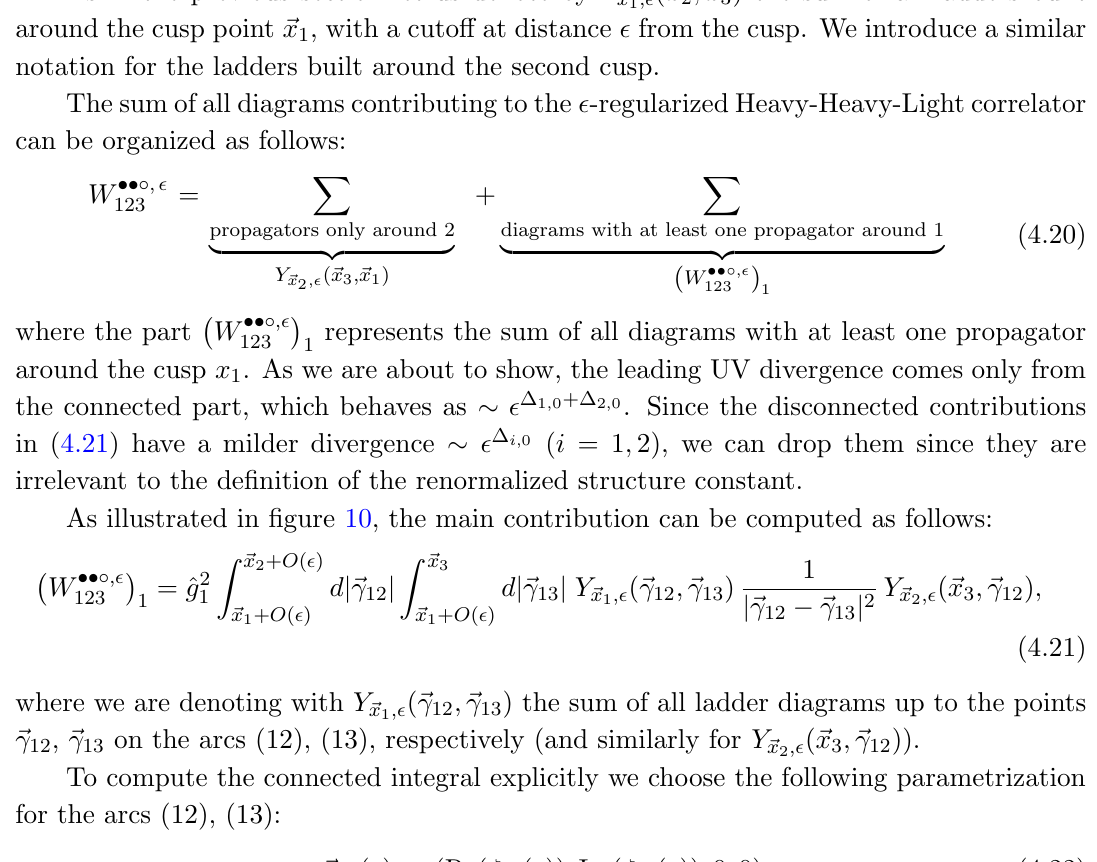
( ~x 3 ;~(cid:13) 12 ) and 2